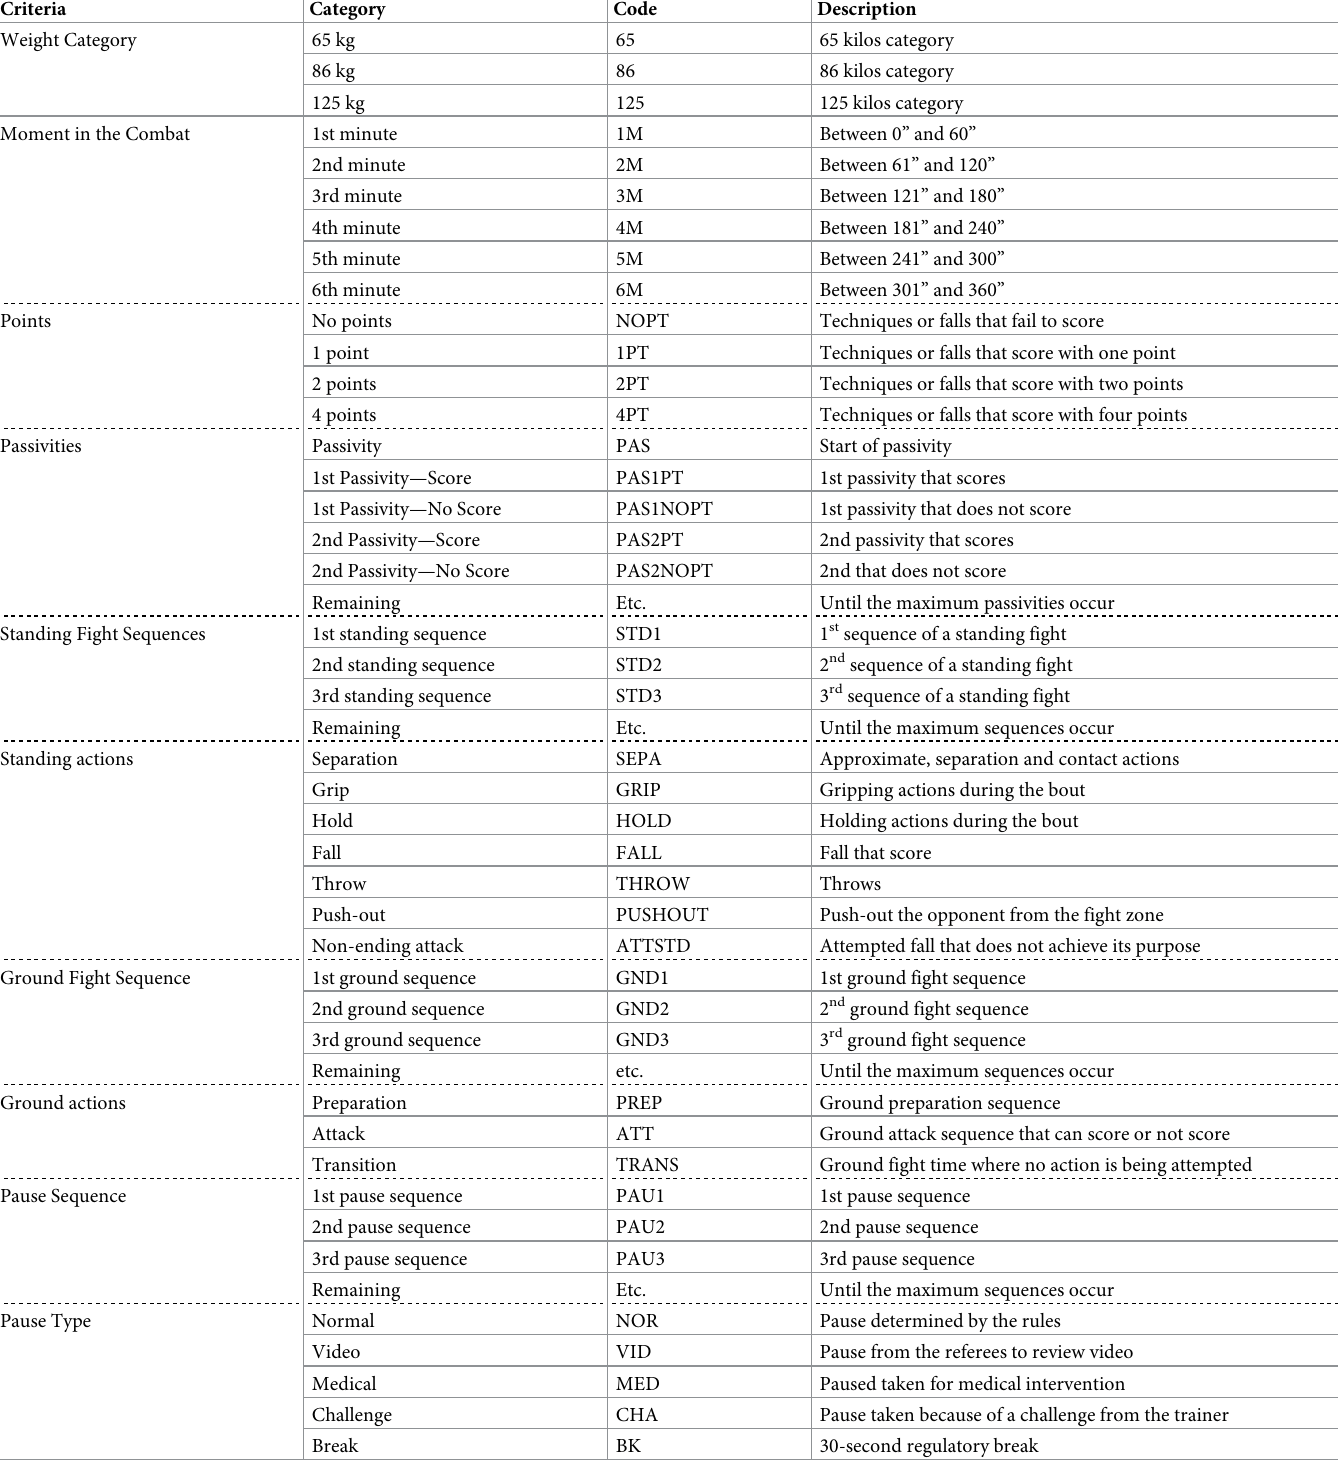
Table 2. Observational